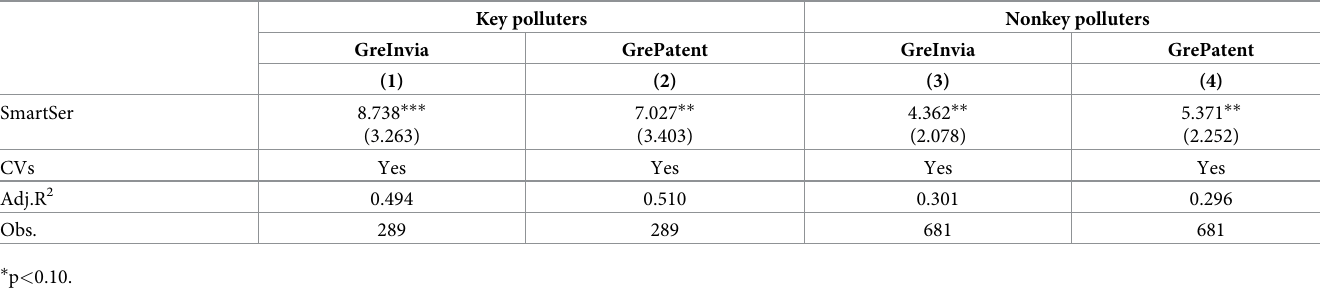
Table 10. Results of environmental hazard heterogeneity.